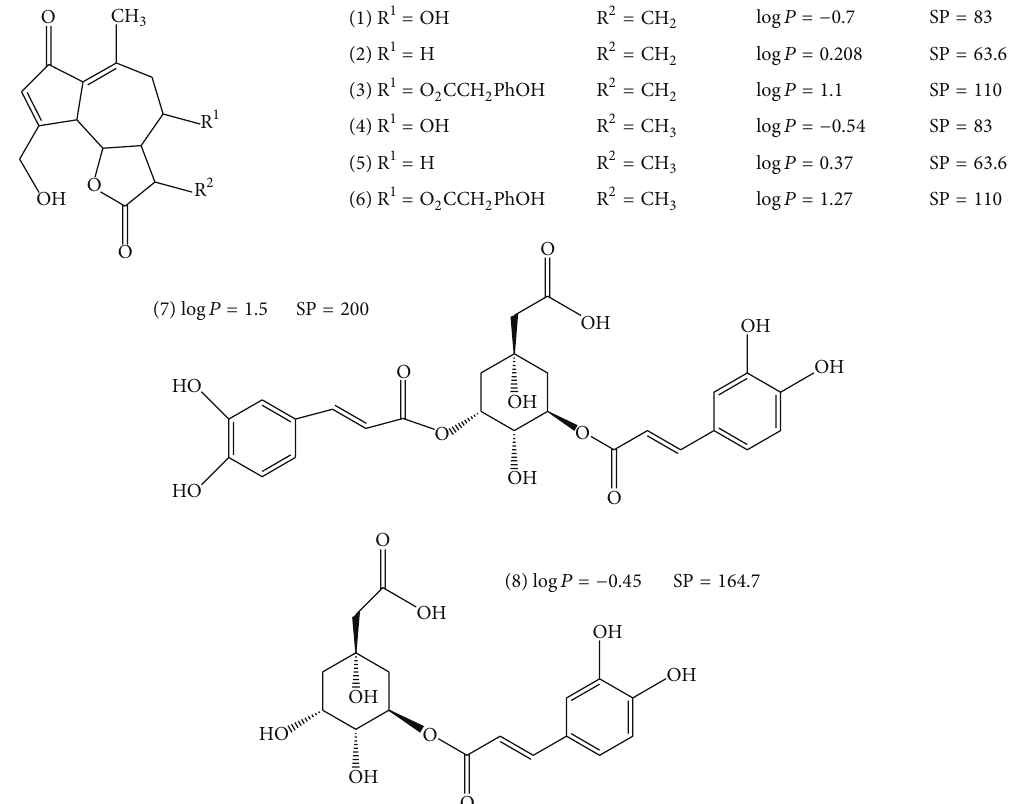
Figure 1: Structure, log 𝑃 values, and surface polarity (SP) of the six sesquiterpene lactones: lactucin (1), 8-deoxylactucin (2), lactucopicrin (3), 11(S),13-dihydrolactucin (4), 11(S),13-dihydro-8-deoxylactucin (5), 11(S), 13-dihydrolactucopicrin (6), and two chlorogenic acids: